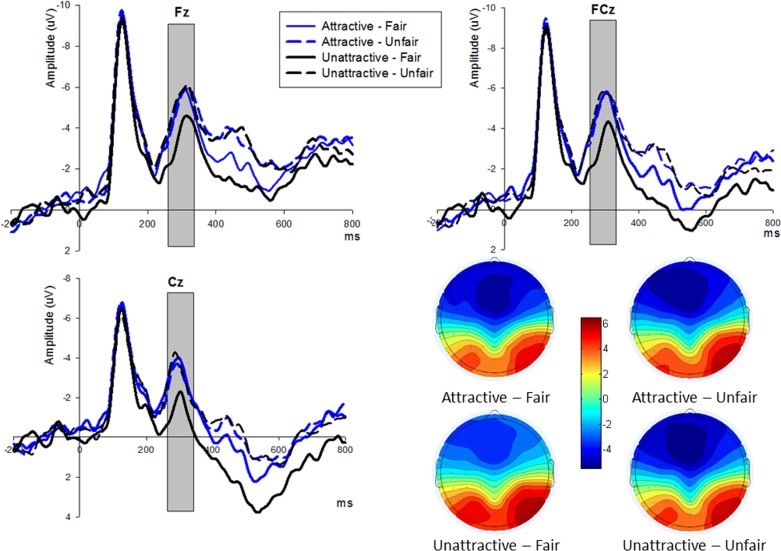
The ERP grand-average waveforms and topographic map of FRN.(A) Fz, FCz, and Cz were selected for FRN (shaded 260–320 ms) waveforms to compare fair and unfair offers in the two face conditions. (B) The bar for four offer conditions of FRN topographic map ranges from -5.5μV to 6μV.